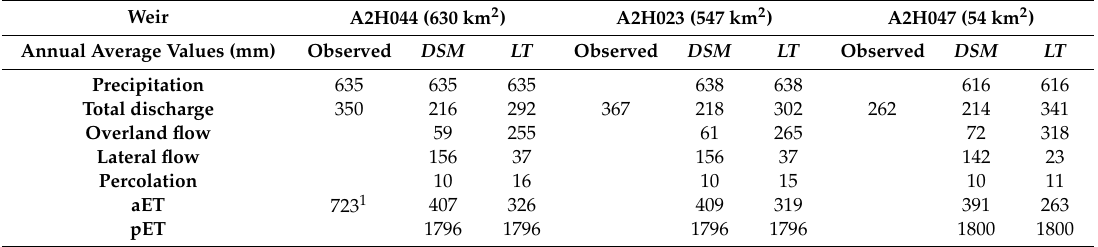
Table 3. Average yearly major water balance components for different simulations for the three studied studied catchments.